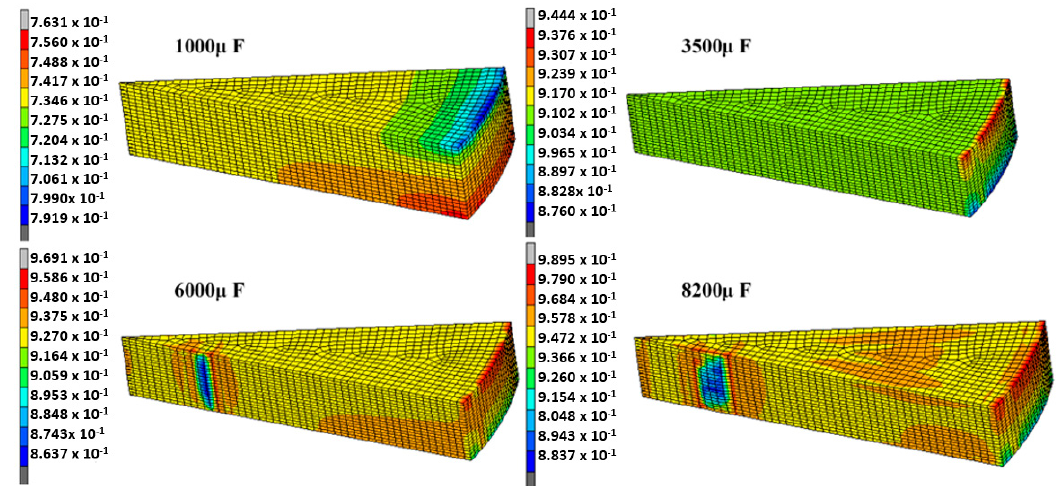
Figure 13. Density distribution on the bar.